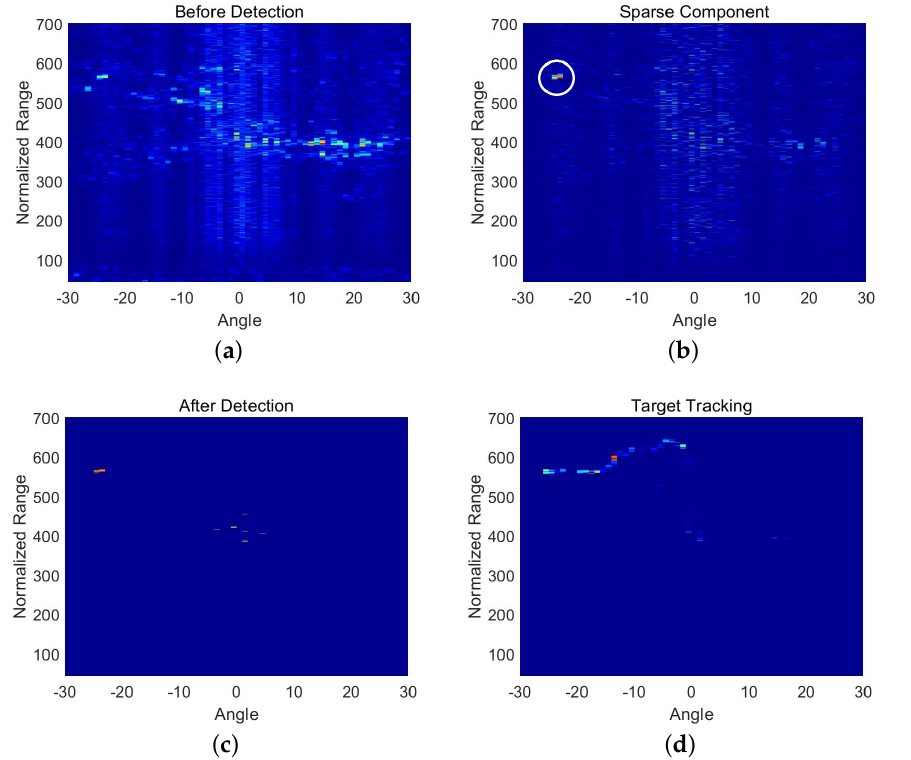
Figure 3. Detection results of an ROV. ( a ) is one frame of data in beamspace before detection; ( b ) is the sparse component of the corresponding frame data; ( c ) is the detection result of corresponding frame data; ( d ) is the trajectorymoving path of the